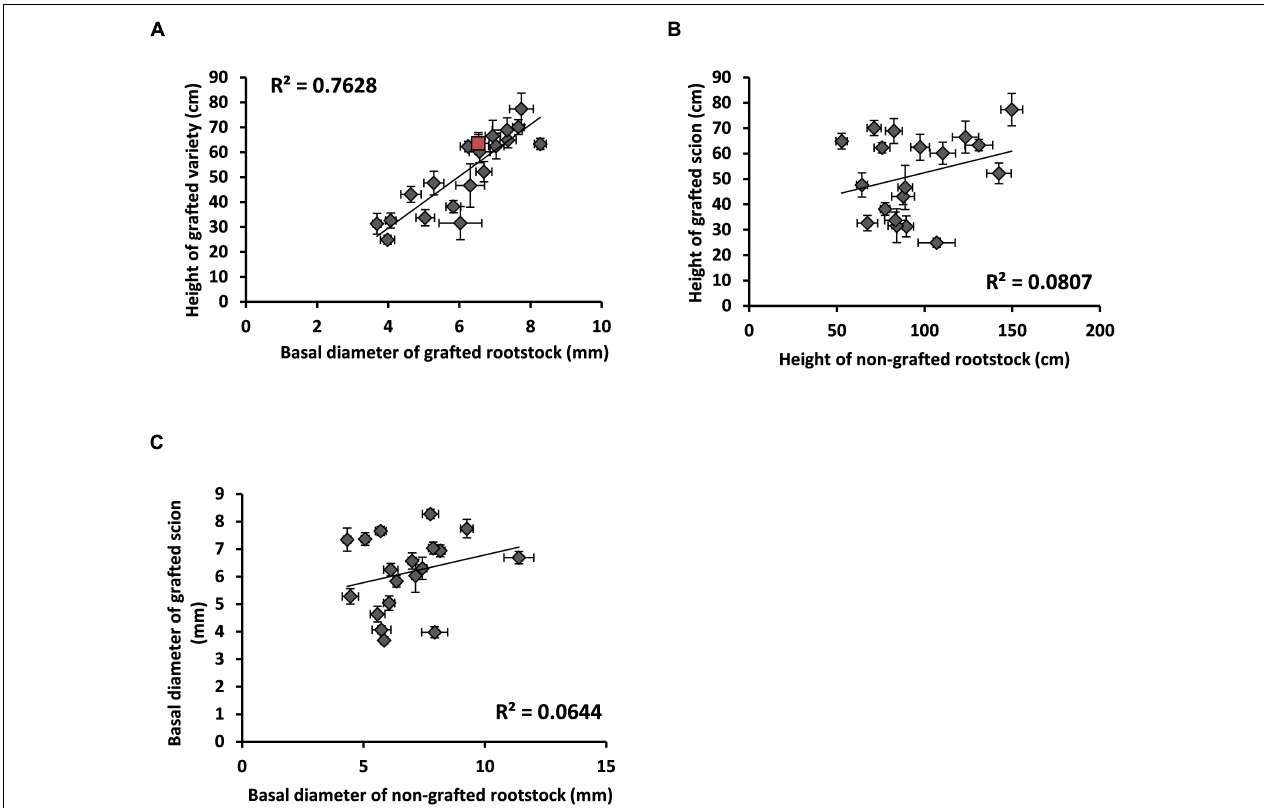
FIGURE 4 | Vigor regulation of the “Picual” scion by wild rootstock genotypes. Wild genotypes grown in pots for 1 year after ex-vitro acclimatization were grafted with the cv. “Picual”. Morphological features were measured 1 year after grafting. (A) Correlation between the rootstock basal diameter and the scion height. Values correspond to the average value of different individuals ( N = 8–12), with self-grafted “Picual” labeled in red color. (B) Correlation between height of the non-grafted rootstock and height of the grafted scion. Values correspond to the average value of different individuals ( N = 8–12) of each genotype. (C) Correlation between the basal diameter of the non-grafted rootstock and the height of the grafted scion. Values correspond to the average value of different individuals ( N = 8–12) of each genotype. Error bars in 2 dimensions (in A–C